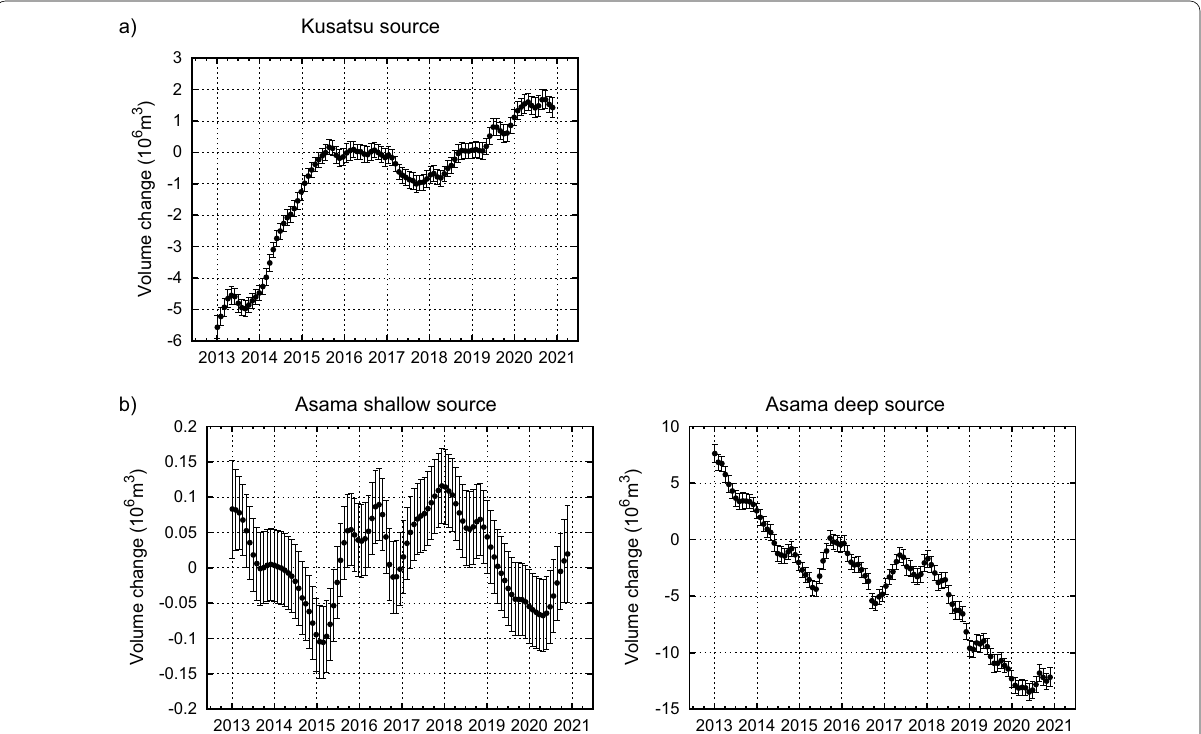
Fig. 6 Estimated volume changes for sources at Kusatsu-Shirane and Asama volcanoes. a Volume changes of the Kusatsu-Shirane source. Error bars correspond to one sigma credible intervals. b Volume changes of the Asama sources. The left and right panels show those of shallow and deep sources, respectively. Error bars correspond to one sigma credible